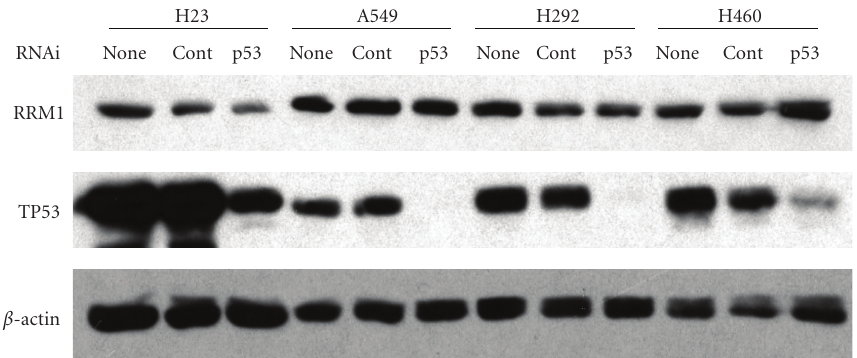
Figure 3: Western blots of knock-down of TP53 expression in four NSCLC cell lines by RNA interference. TP53-specific siRNA reduced TP53 protein expression to undetectable levels in A549 and H292 and greater then 10-fold in H23 and H460, while random control siRNA did not a ff ect TP53 or RRM1 expression.